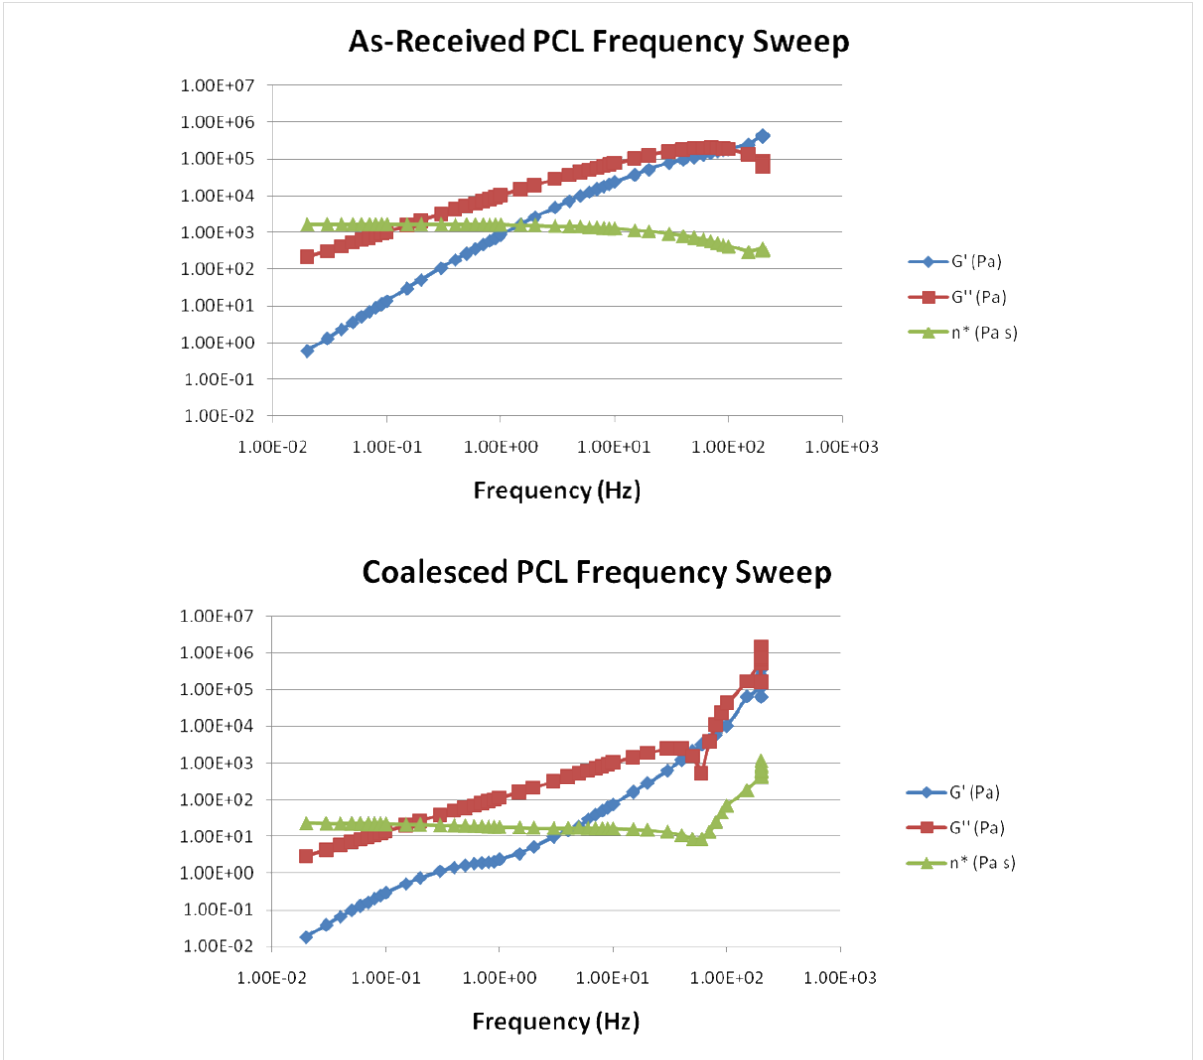
Figure 10: Storage modulus, loss modulus, and apparent viscosity (G’, G’’, and n*, respectively) for asr- and c-PCL melts, (top and bottom, respect- ively), as obtained through oscillatory melt rheology ( T = 90 °C; testing stress = 750 Pa; pretest hold time = 1 minute) [65,70].